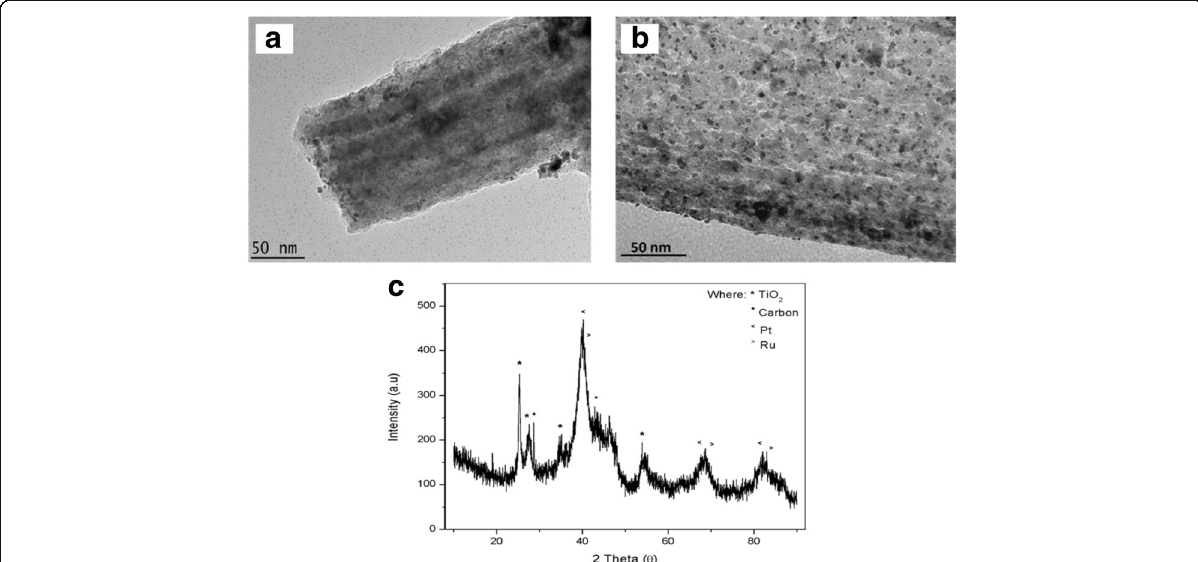
Fig. 11 Image of PtRu deposited on TiO 2 -CNF a TEM image of PtRu/TiO 2 -CNF in F0.1, b TEM image of PtRu/TiO 2 -CNF in D18, and c XRD pattern of